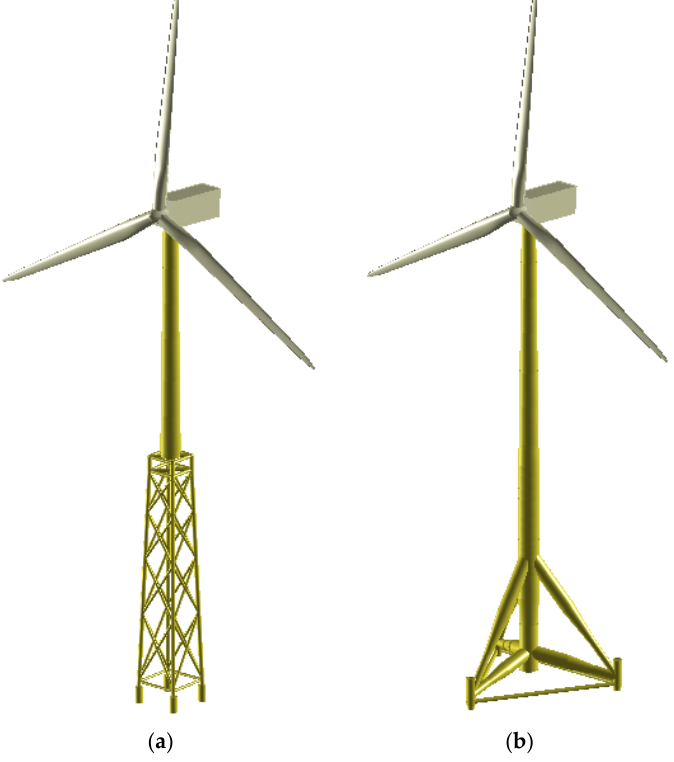
Figure 1. Test structures: ( a ) Jacket; ( b ) Tripod.